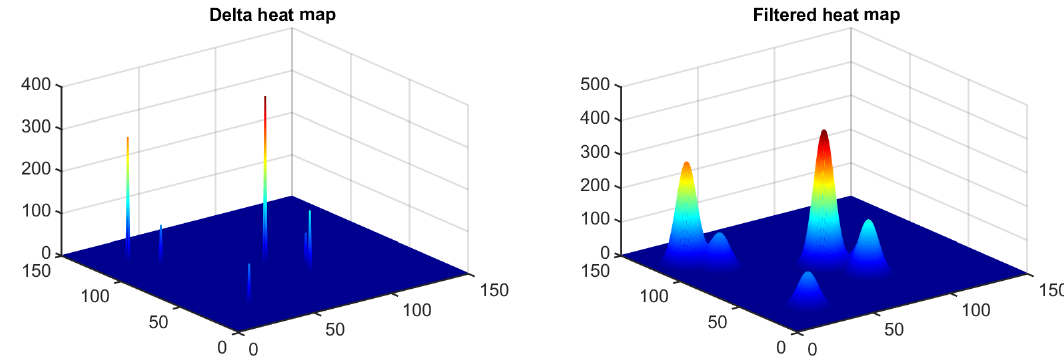
Figure 3. Sample heat map with a size of 150 × 150 pixels. ( Left ) Raw delta heat map. ( Right ) Same heat map after applying the Gaussian filtering.